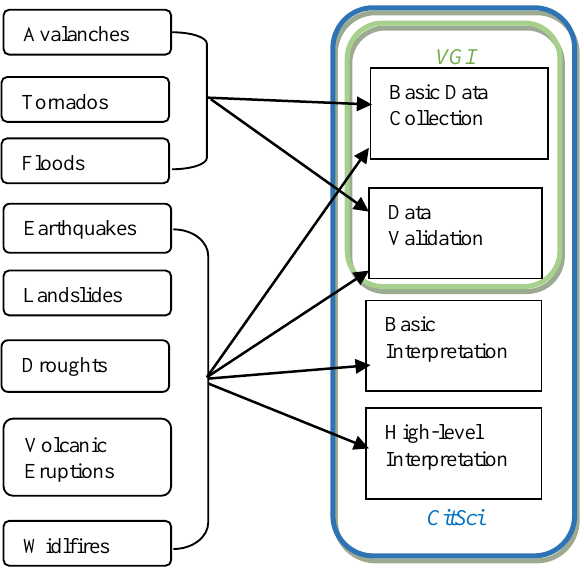
Figure 1. Natural hazard types and the use cases of CitSci and VGI in these research fields.